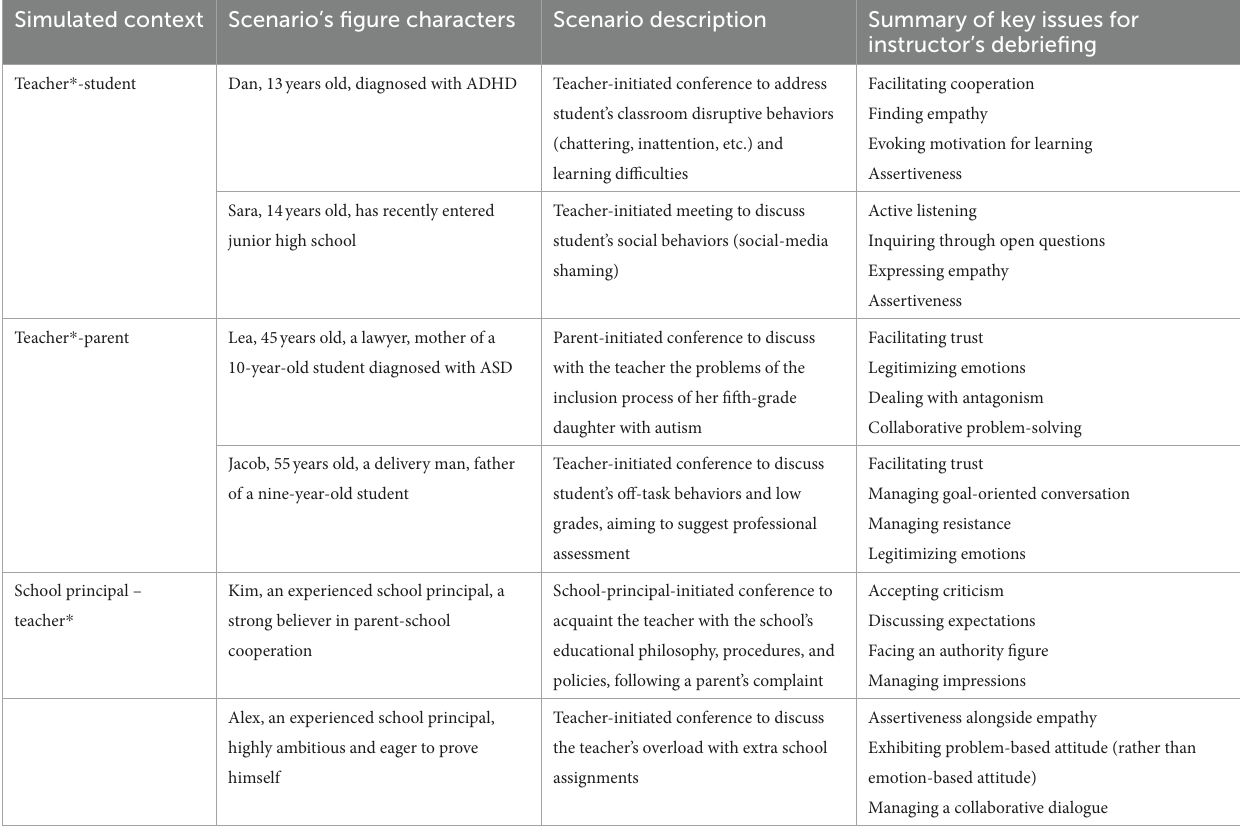
TABLE 1 A sample of simulation scenarios: Contexts, descriptions, goals, and key issues for instructor’s debriefing. Simulated context Scenario’s figure characters Scenario